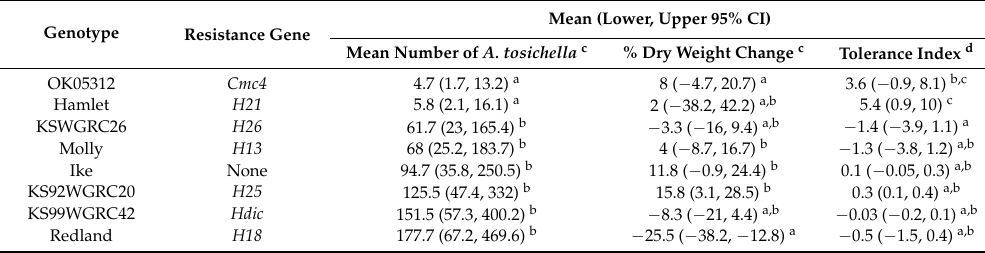
Table 1. Mean (Lower, Upper 95% CI) total A. tosichella biotype 1 adults and nymphs, percent proportional plant dry weight change a and plant tolerance index b of M. destructor resistant wheat cultivars, the susceptible cultivar Ike and the A. tosichella resistant cultivar OK05312 at 14 days post- A. tosichella -infestation in no-choice antibiosis and tolerance tests. Genotype